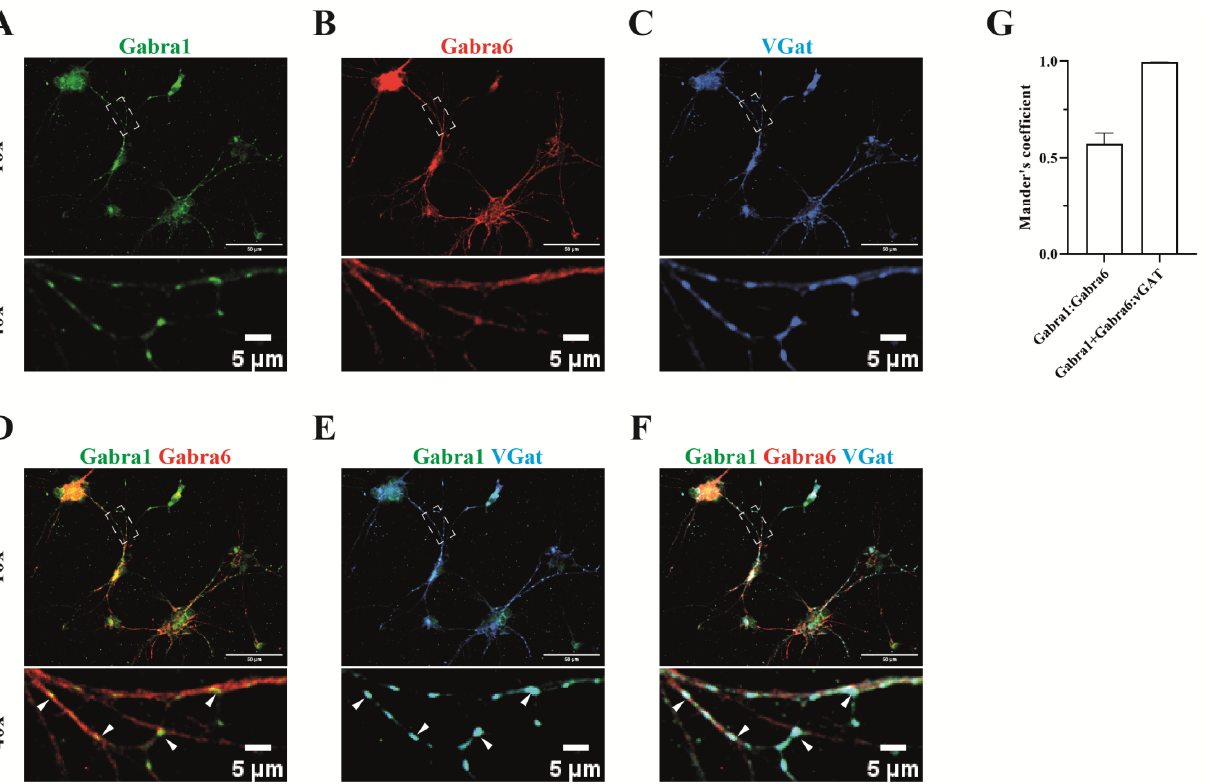
Figure 5. Synaptic localization of α 1/ α 6 containing GABA A receptor. The distribution of both α 1 and α 6 subunits was investigated on the cerebellar granule cells ( A , B ) and both subunits were each co-stained with the inhibitory GABAergic presynaptic neuronal marker protein vGAT ( C ). α 6 immunoactivity was present along the neurite. α 1 was predominately present in synapses opposing the pre-synaptic vGAT ( E ), where α 6 also often co-localized (indicated by arrow heads, D , F ). ( G ) Manders’ coefficient indicates the overlap of α 1 subunit (green channel) with α 6 subunit signal (red channel). The co-localized puncta between the α 1 and α 6 subunits over vGat (blue channel) are indicated by Manders’ coefficients as w/vGat.